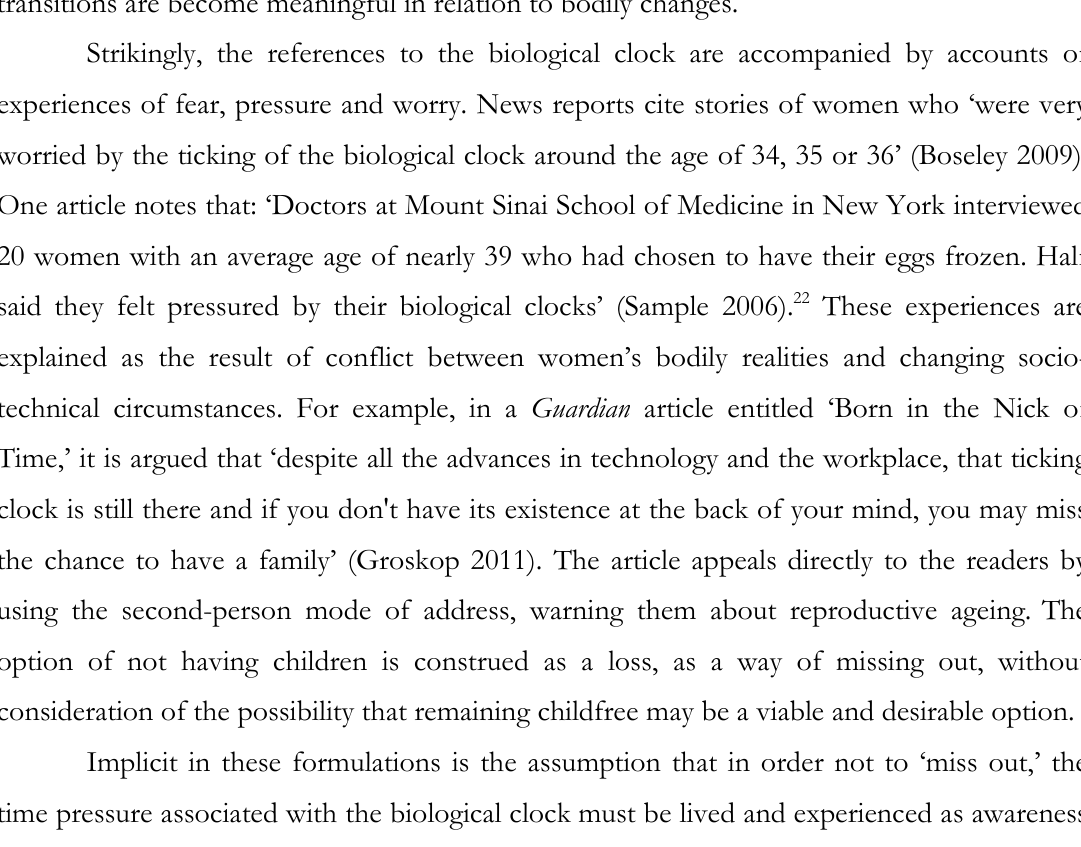
Lucy van de Wiel, For Whom The Clock Ticks: Reproductive Ageing and Egg Freezing in Dutch and British News Media Studies in the Maternal , 6(1), 2014,